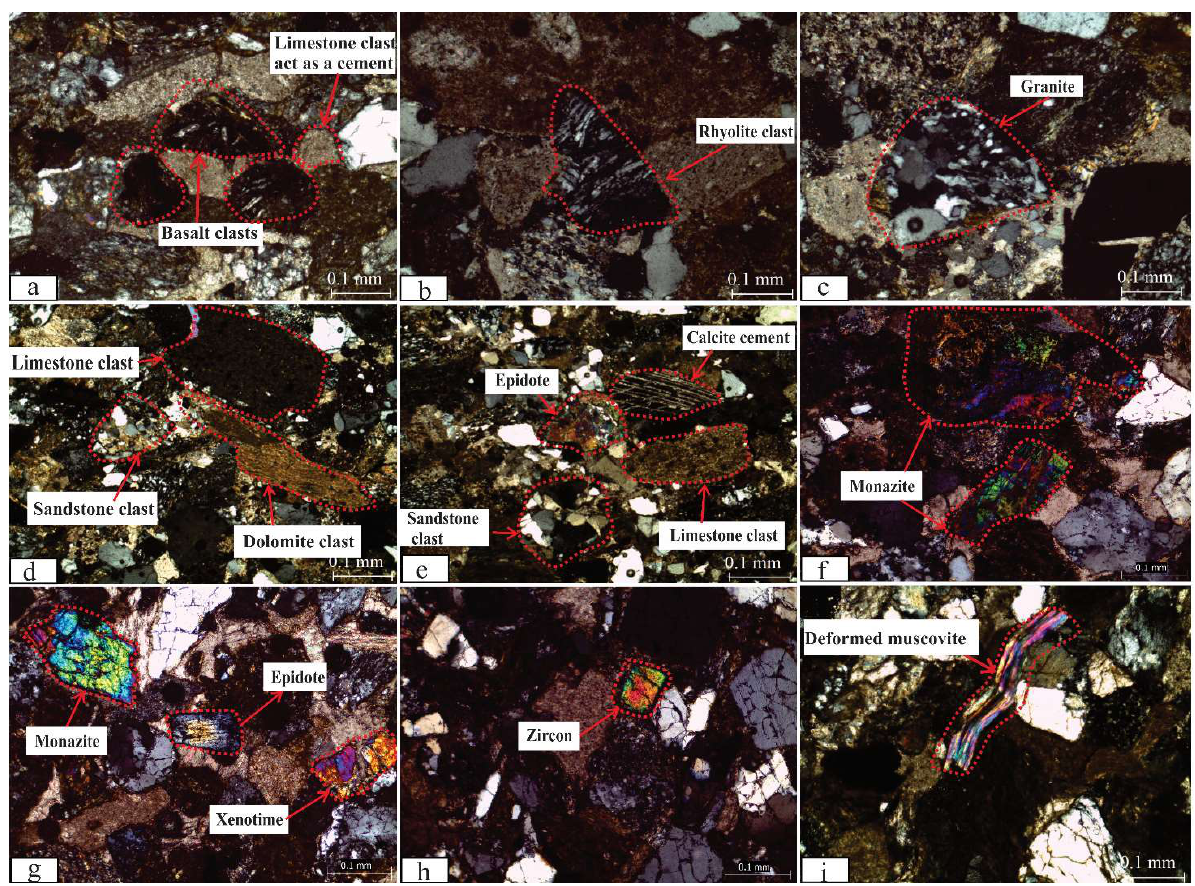
Figure 7. Photomicrographs showing ( a ) basalt clasts and limestone clasts acting as cementing material, ( b ) rhyolite clast, ( c ) granite clast, ( d ) sandstone, limestone and dolomite clasts, ( e ) calcite cement, epidote, limestone and sandstone clast, ( f ) monazite, ( g ) monazite, xenotime and epidote, ( h ) zircon, and ( i ) deformed muscovite .